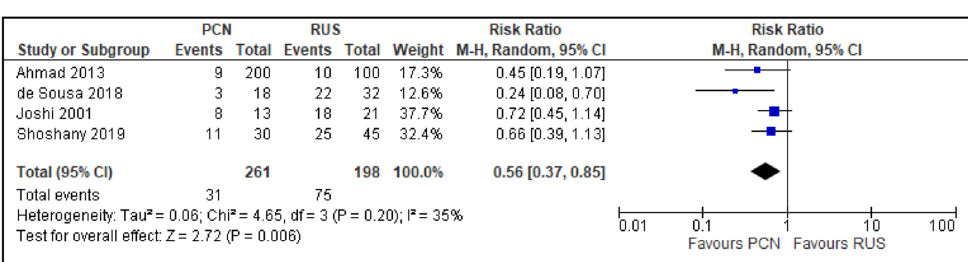
Figure 12. Comparison between PCN and RUS for outcome haematuria.